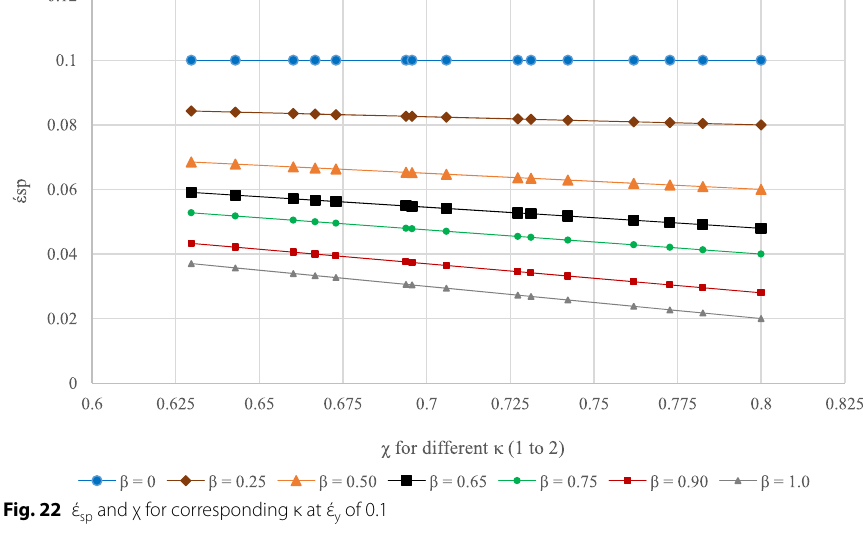
Fig. 22 έ sp and χ for corresponding κ at έ y of 0.1